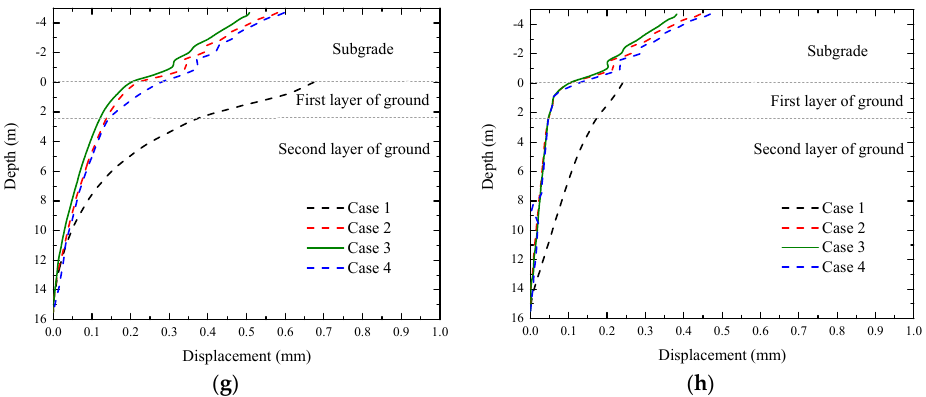
Figure 13. Vibration responses: ( a ) Pore water pressure without piles, ( b ) pore water pressure with piles, ( c ) effective stress without piles, ( d ) effective stress without piles, ( e ) total stress without piles, ( f ) total stress with piles, ( g ) displacement without piles, and ( h ) displacement with piles.